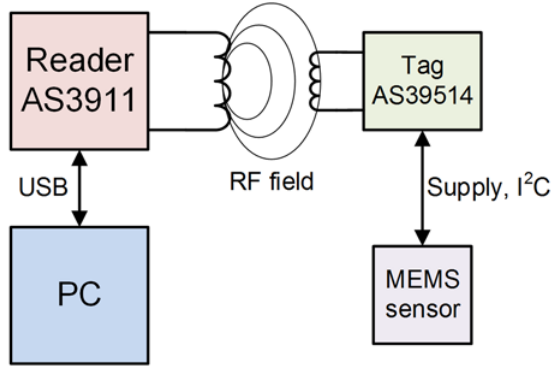
Figure 2. Block diagram of the measurement setup.